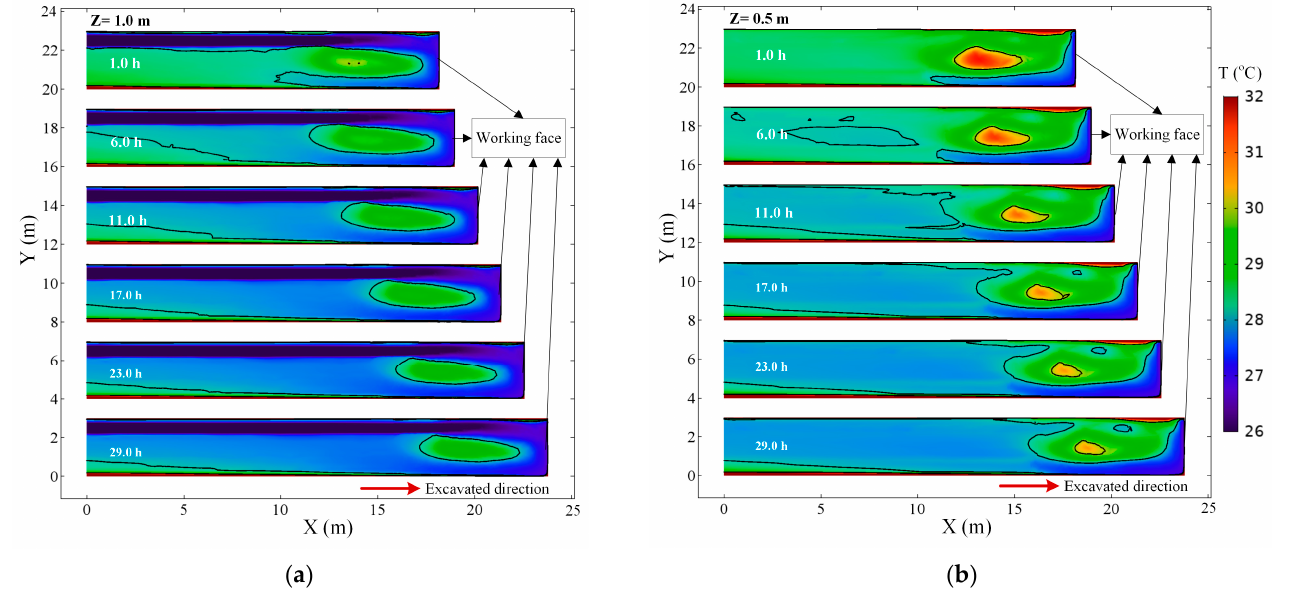
Figure 4. Air temperature distribution in the roadway at different times: ( a ) air temperature field in the Z = 0.5 m plane;